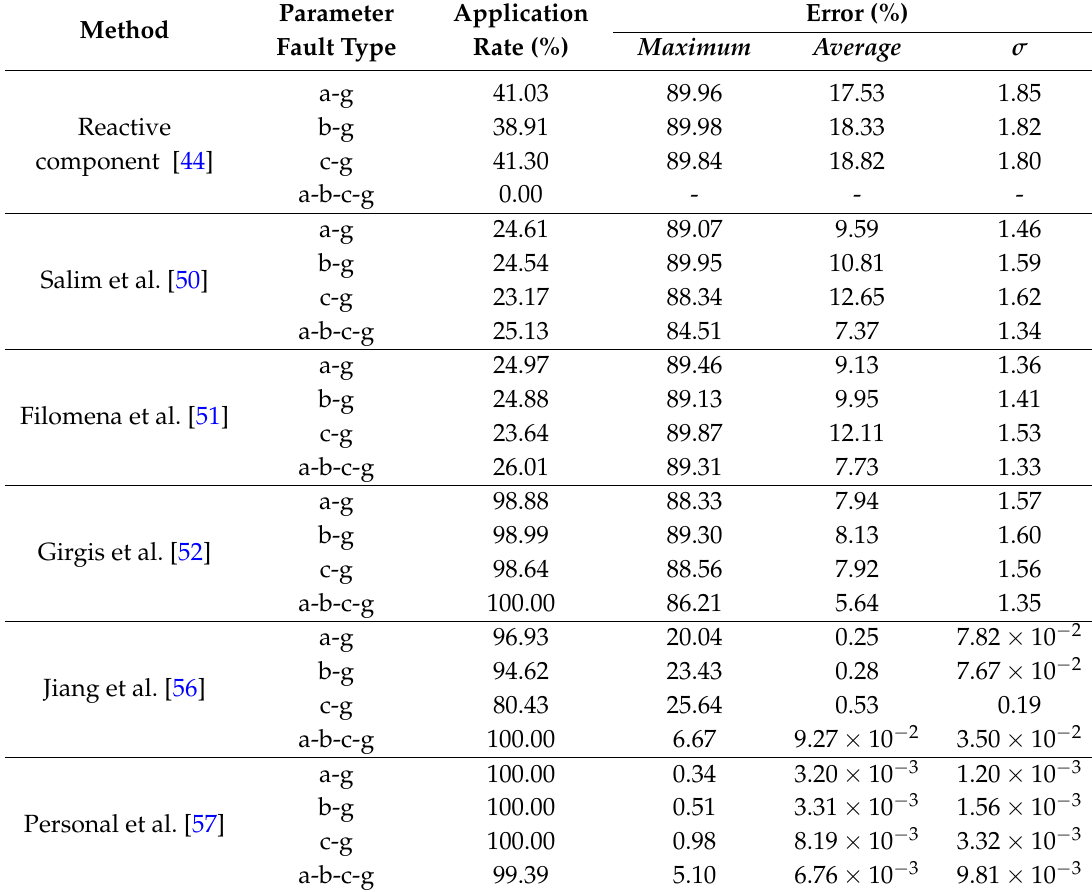
Table A1. Fault type